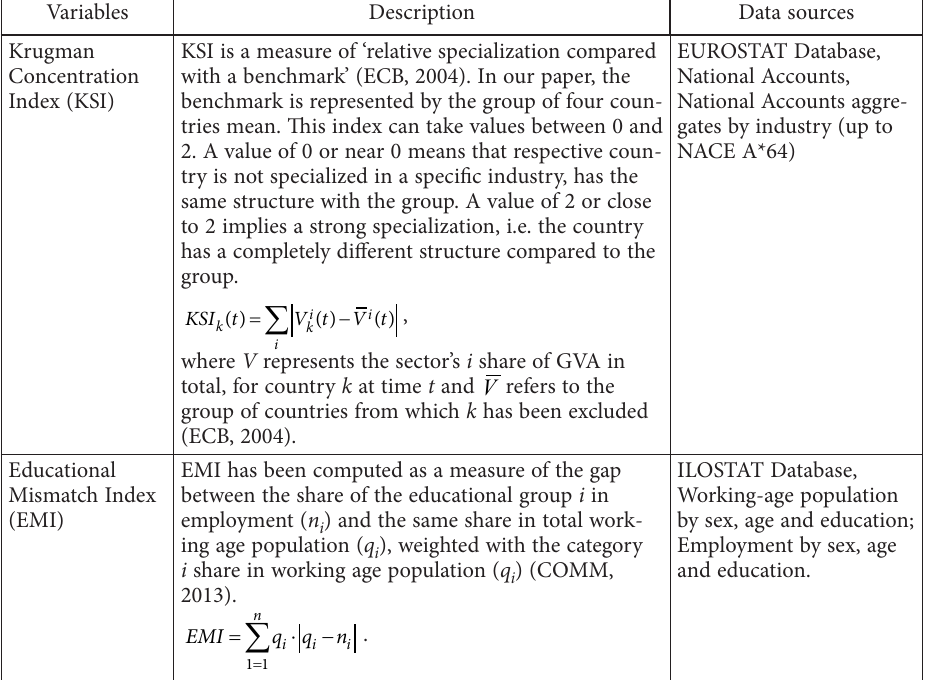
Table 1. Variables description and data sources